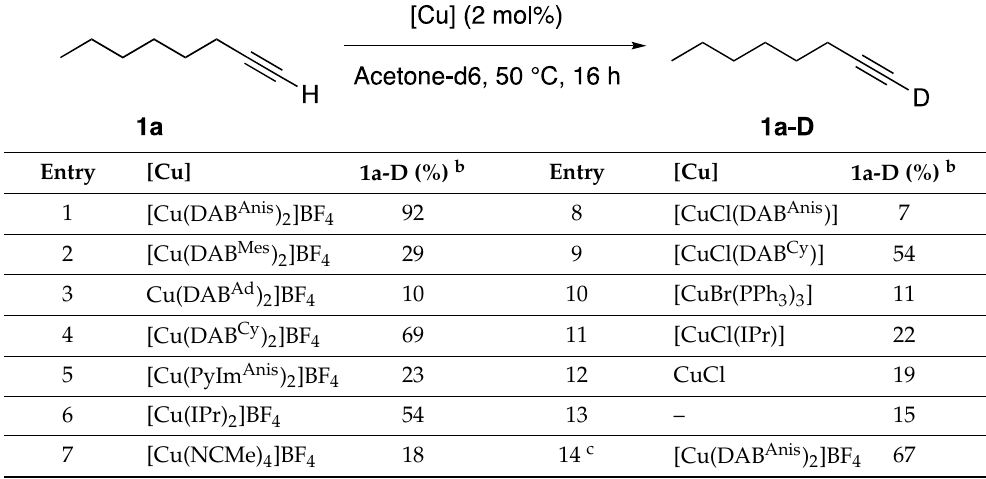
Table 2. Final optimisation a